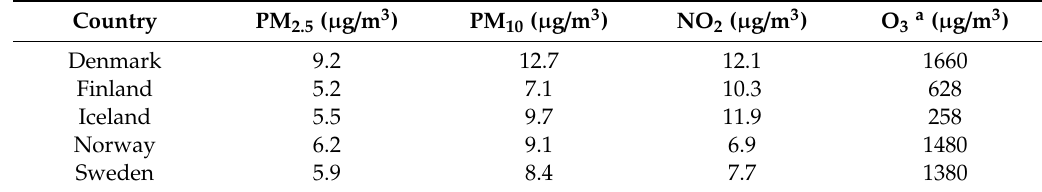
Table 5. Population-weighted concentrations for Nordic countries in 2015.